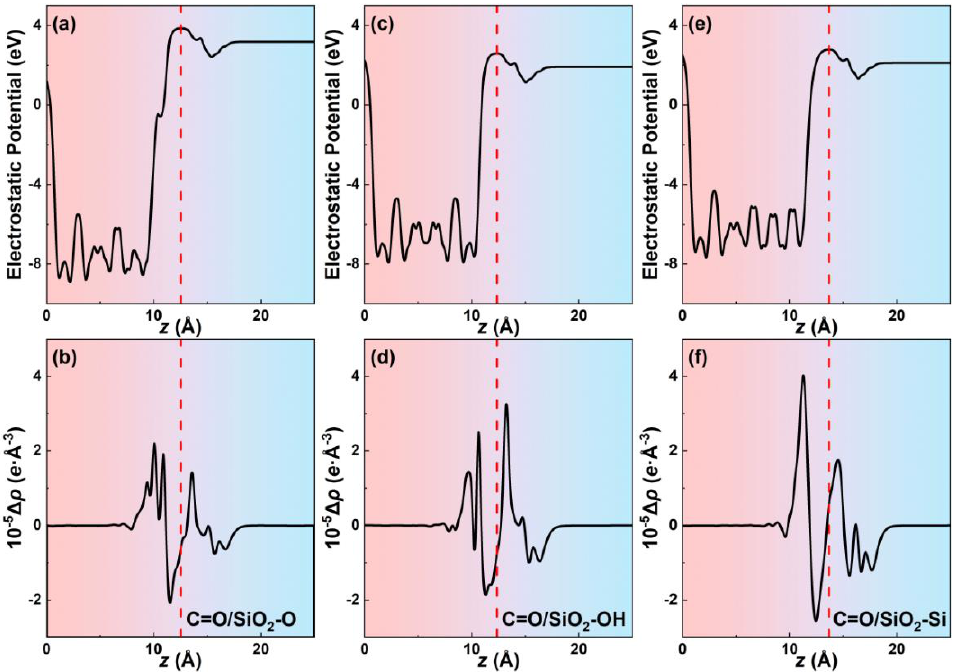
Figure 3. The plane-average electrostatic potentials along the z direction of the ( a ) C=O/SiO 2 -O, ( c ) C=O/SiO 2 -OH, and ( e ) C=O/SiO 2 -Si systems. The plane-average charge density differences along the z direction of the ( b ) C=O/SiO 2 -O, ( d ) C=O/SiO 2 -OH, and ( f ) C=O/SiO 2 -Si systems.